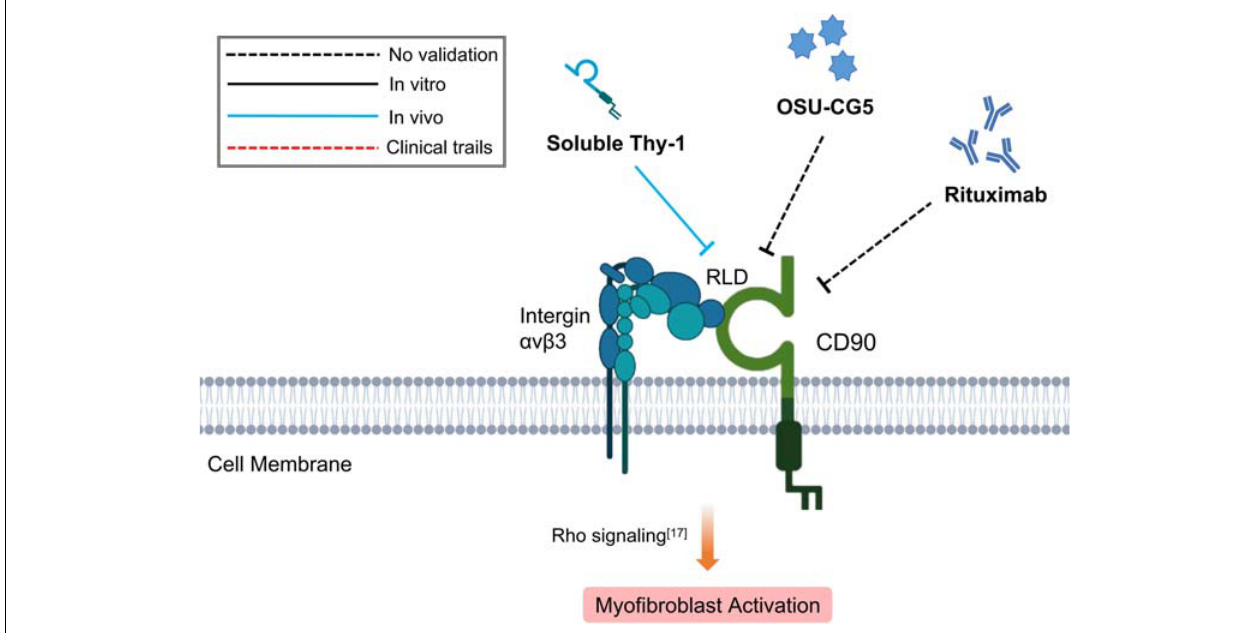
FIGURE 1 | Schematic graph showing potential antifibrotic therapies targeting CD90. (RLD, RGD-like tripeptide).